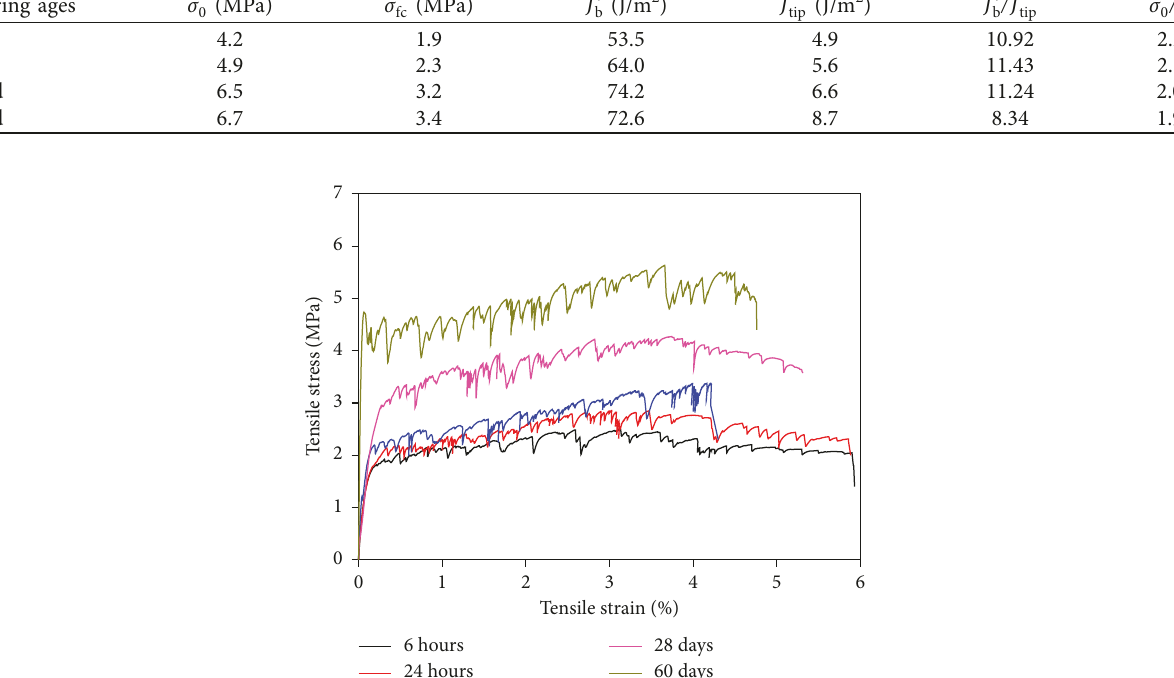
Table 6: Performance indices of strain-hardening for HES-ECCs when PE fiber content is 0.8% (ECC4). Curing ages σ 0 (MPa) σ fc